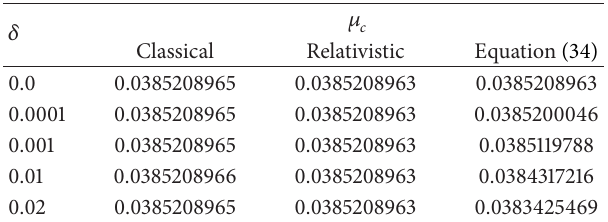
Table 8: Critical Mass. Sun-Uranus system: 𝑐 = 44056.13 , 𝜇 = = 0.0000000070 × 10 −8 0.000043548000 , and 𝐴 2